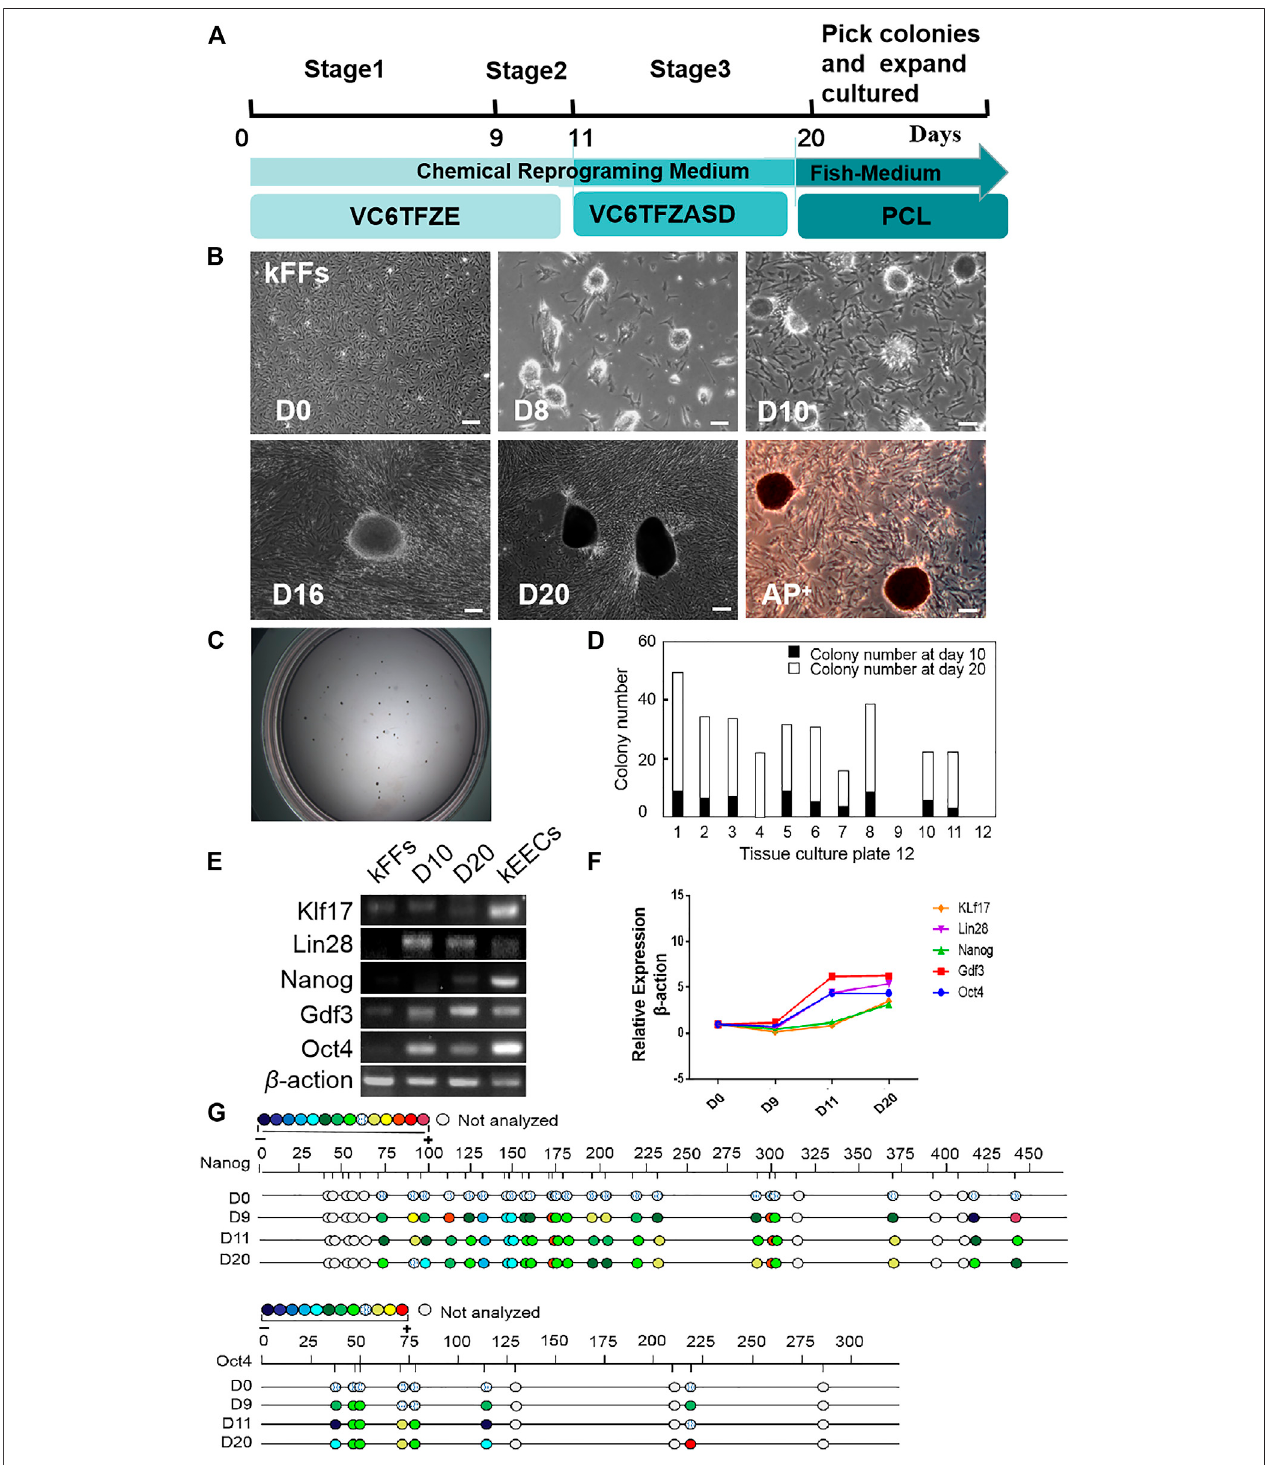
FIGURE 1 | Generation of iPS-like Cells from Kio fi n fi broblasts (kFFs) by small-molecule compounds. (A) Schematic of the optimized protocol (V, VPA; C, CHIR 99021; 6, 616452; T, tranylcypromine; F, forskolin; Z, DZNep; E, EPZ004777; A, AM580; S,SGC0946; D, 5-aza-dC; P, PD025901; L, LIF). (B) The time course and cell morphology of chemical reprogramming of kFFs using the optimized protocol. Dense epithelioid colonies were observed on the eighth day and proliferated with the passage of time. On the 10th day, clear-edged, mindless clones appeared. In the third stage, the number of clones increased signi fi cantly, the size of clones increased, and the alkaline phosphatase test showed positive. Scale bars, 100 μ m. (C) The bright image of colonies in a 30 mm Petri dish at day 20. (D) The number of